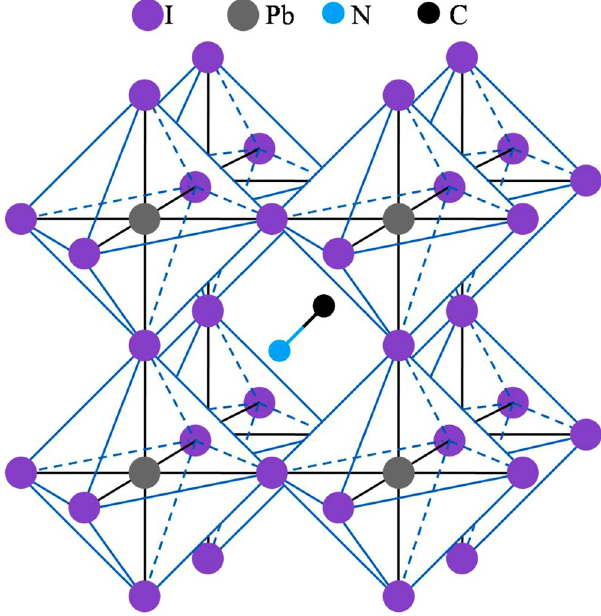
Figure 1. Crystal structure of MAPI perovskite. H atoms were omitted for